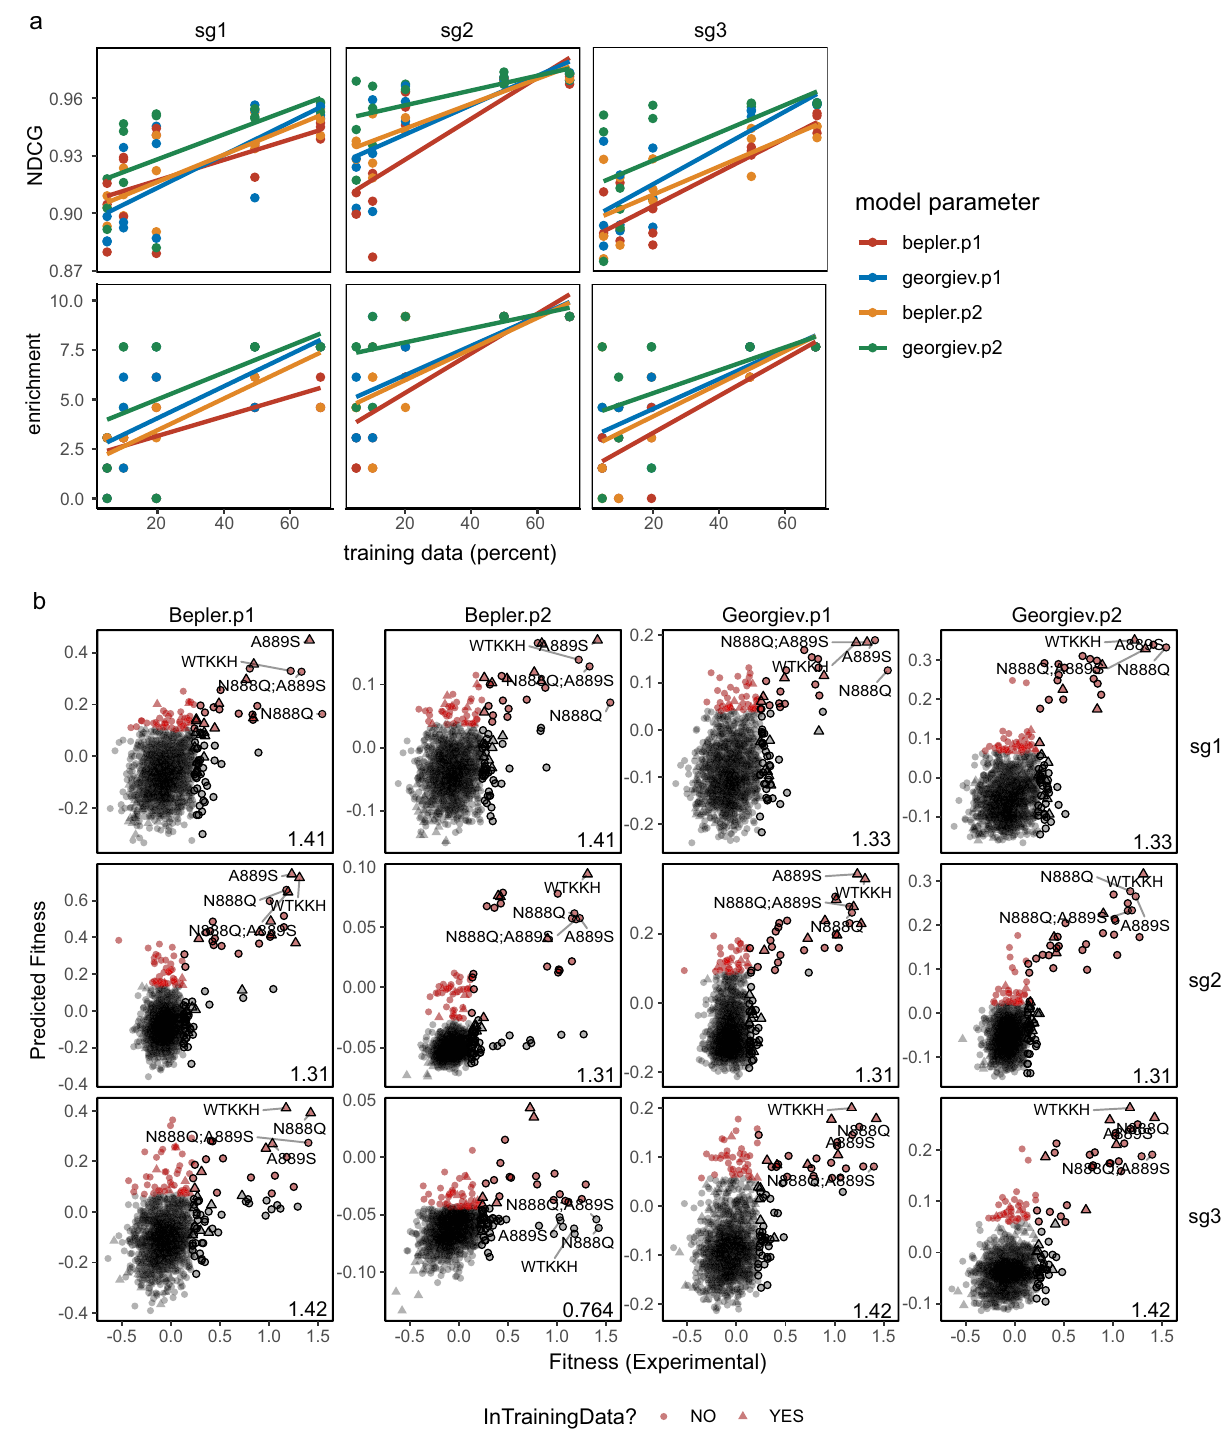
Fig. 3 MLDE predictions on KKH-saCas9 ’ s on-target activity with three sgRNAs. a Enrichment and NDCG of MLDE runs using a combination or embeddings (Bepler/Georgiev) and models (p1 and p2) are plotted against the size of training data. The best- fi t line summarizes 3 replicates for each embedding and model parameter combination of MLDE runs using 5, 10, 20, 50, and 70% of training data. b Predicted versus empirical fi tness of variants in the best-performing MLDE runs using 20% input training data, given the different combinations of embeddings and model parameters. The predicted fi tness by MLDE is plotted against the empirical fi tness of the on-target activity of KKH-SaCas9 with three sgRNAs (sg1, sg2, and sg3) in the best- performing runs (ranked according to the NDCG and enrichment score). The values of maximum fi tness in the training data are indicated at the bottom- right corner of each panel. The top-5% hits in the prediction are highlighted in red, while the top-5% variants from the empirical data are outlined in black. Wild-type KKH-SaCas9 (WT-KKH) and top-performing variants N888Q, N888Q/A889S, and A889S are labeled. The source data are provided as a Source Data fi